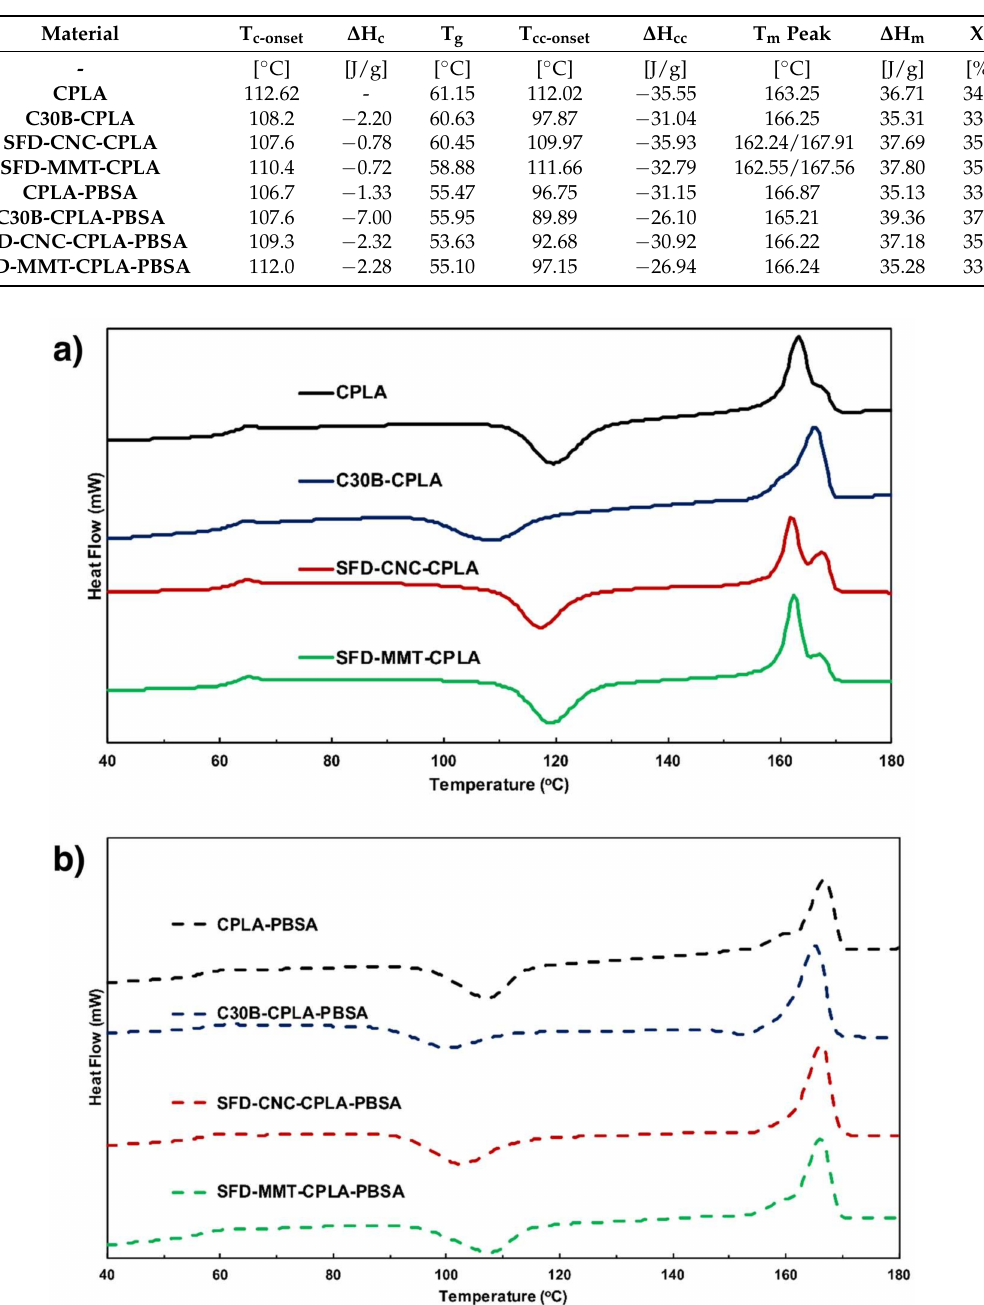
Figure 9. DSC endotherms from second heating experiments of ( a ) CPLA and ( b ) CPLA-PBSA